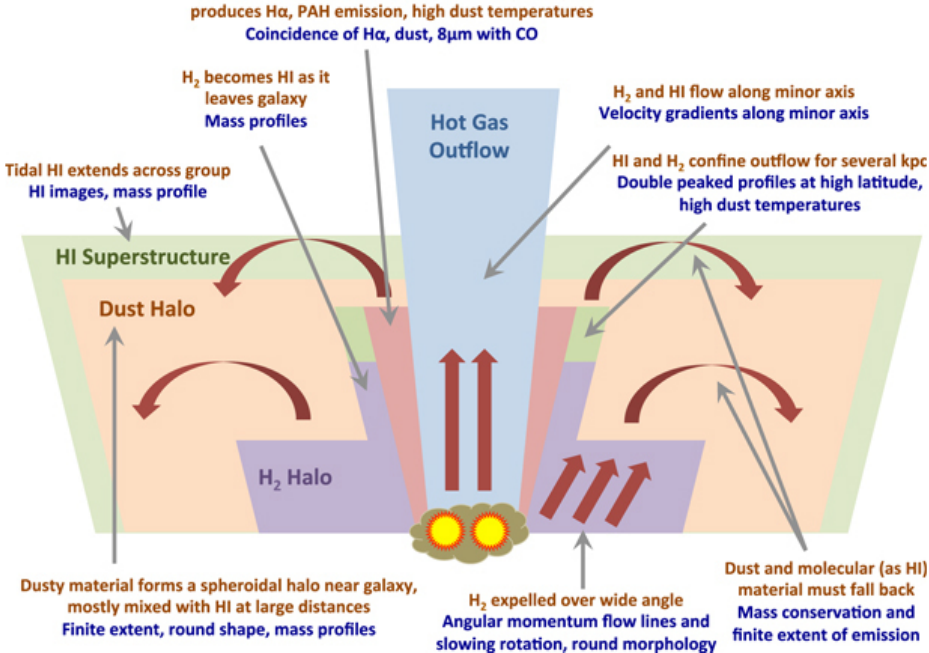
Figure 2. A schematic of the multiphase wind (and fountain) in M82. The blue notes in the figure cite observational evidence for the red statements. Similar schematic has been made for NGC 253 [113,116]. Figure reproduced with permission from Leroy et al. ApJ, 2015